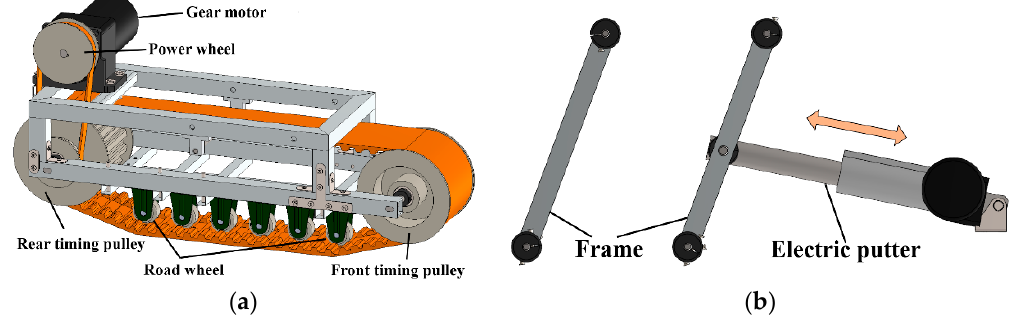
Figure 2. ( a ) CAD model of the crawler. ( b ) CAD model of the pantograph bracket.